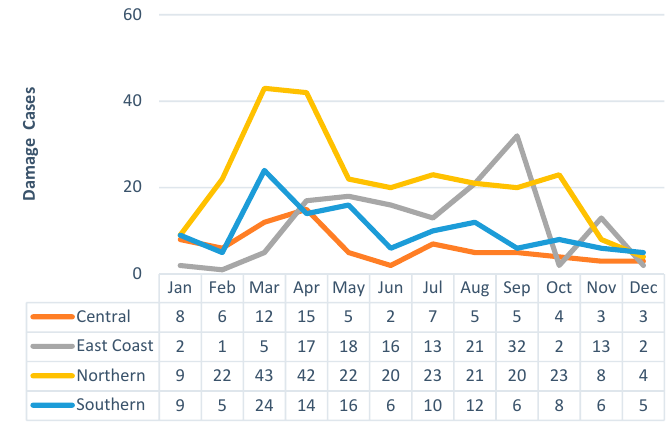
Figure 1. Windstorm occurrence based on location and date between 2000 and 2012 in Peninsular Malaysia.